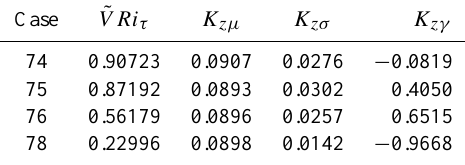
Table 4. List of the parameters K zµ , K zσ , and K zγ , calculated from the sediment diffusivity profiles of the cases listed in Table 3.